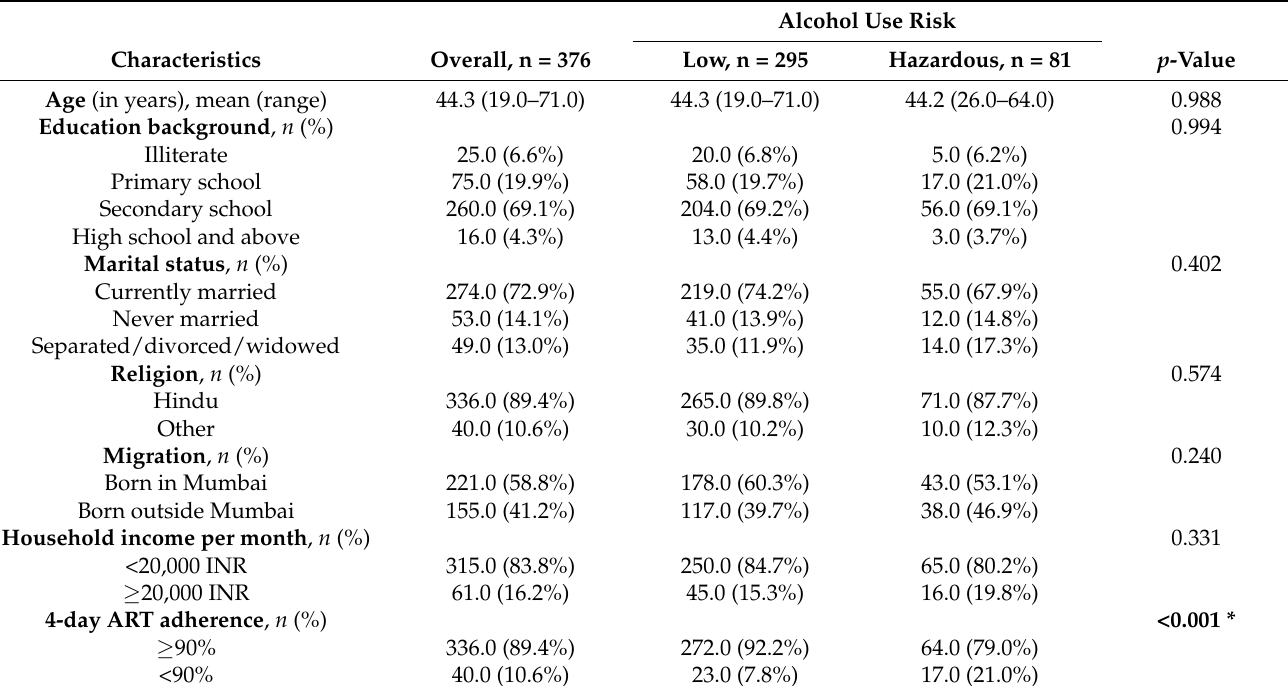
Table 2. Sample characteristics stratified by alcohol use at T1 among control participants (n = 376). Alcohol Use